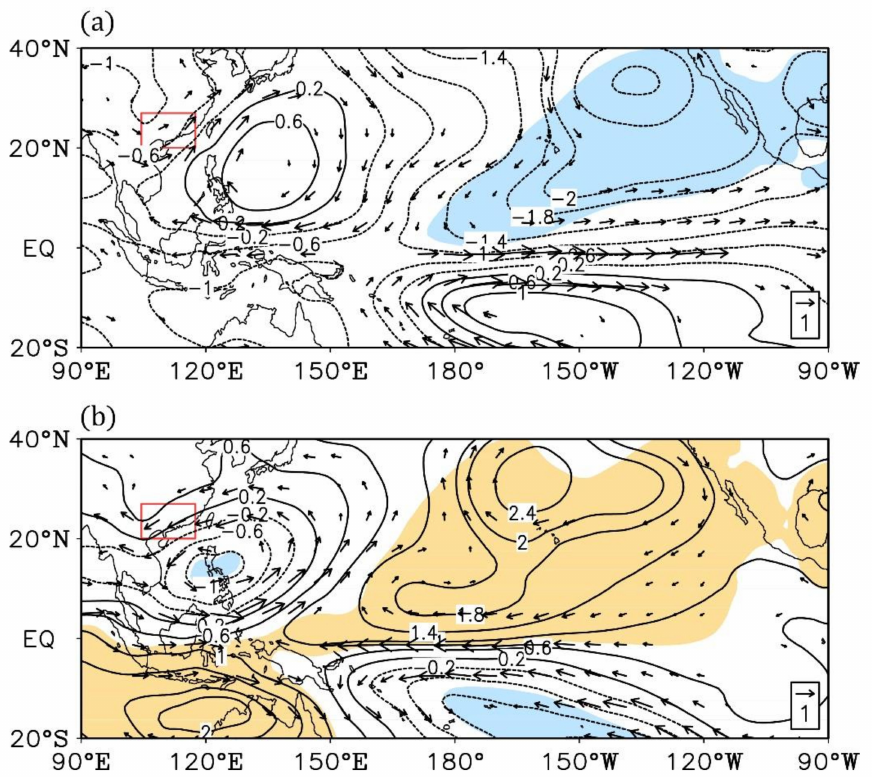
Figure 5. Composite anomalies of the decaying spring stream function (contours; units: m 2 s − 1 ; the colored areas are significant with p < 0.1) and rotational wind (arrows; units: m s − 1 ; only arrows significant with p < 0.1 are shown) at 850 hPa for the ( a ) El Niño cases and ( b ) La Niña cases. All data are linearly detrended. The red boxes denote the South China